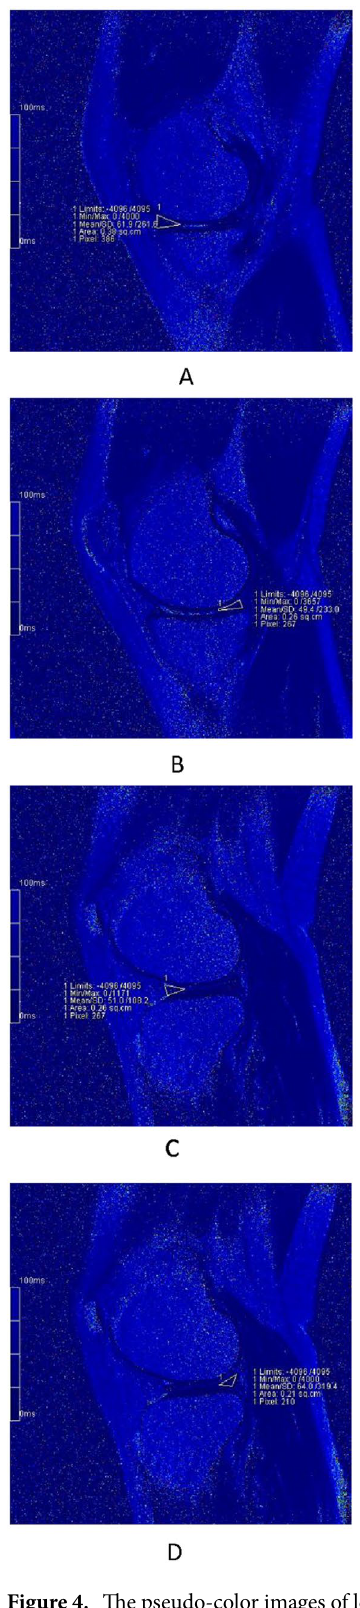
Figure 4. The pseudo-color images of left knee of a 28-year-old female at three timings. ( A )–( D ) are the images 12 h after the match. Fig. A/B/C/D are the images MMAH/MMPH/LMAH/LMPH respectively. The T2 values accordingly were 61.9 ms, 49.4 ms, 51.0 ms, 64.0 ms,